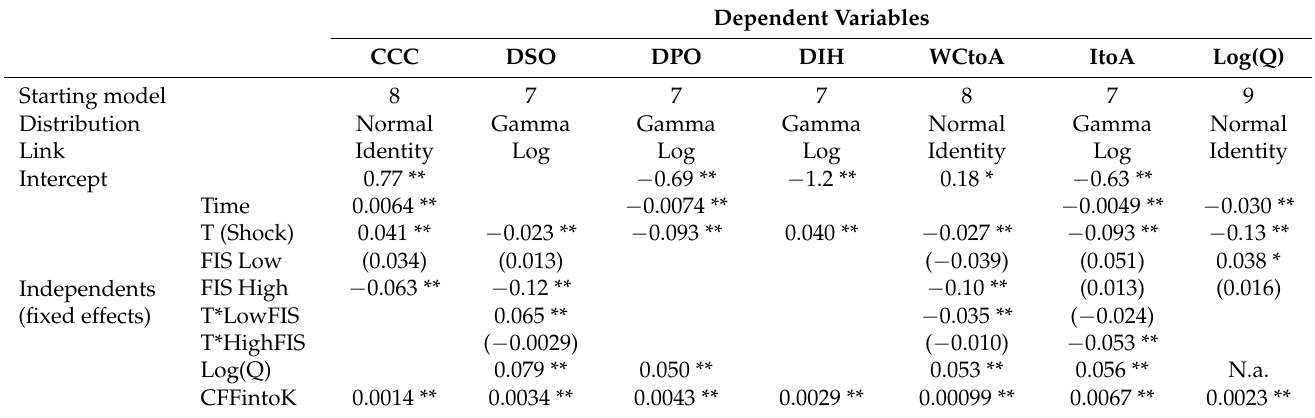
Table 5. Model-based results (models 7 to 9). The starting model, applied link function and distribu- tions are shown. The coefficients for fixed effects shown are from the final models that include only the significant coefficients except when the interaction term was significant but some of the main effects were not. In these cases, the main effect(s) are also included and shown. The sector and region were included in the model as random effects that cannot be generalized (coefficients not shown). The fixed effect coefficient values have no simple interpretation because of the existence of random effects, logarithmic link function in most cases, interaction terms and the applied transformations. The main effects should not be interpreted when there is an interaction term in the model. However, in our case, the signs and significance of the main effects remain the same if interactions are